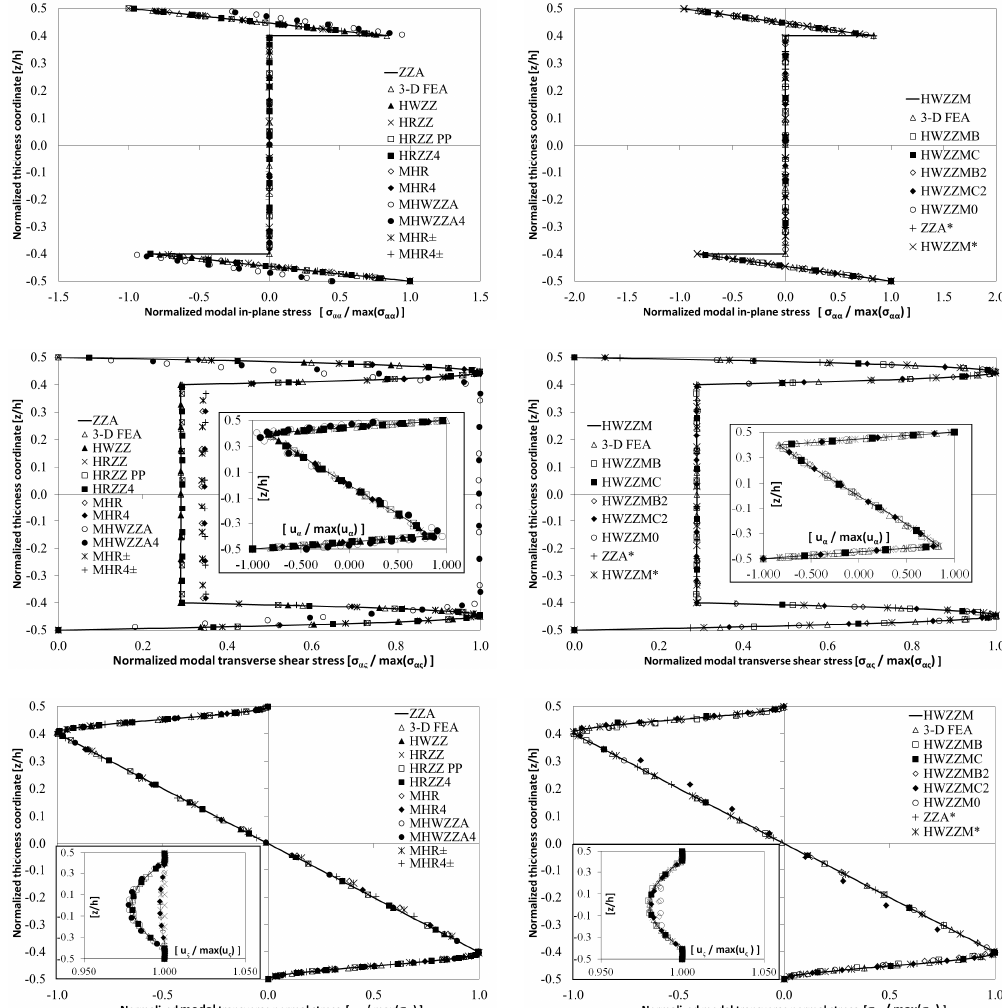
Figure 3. Case b3: Normalized modal displacements and stresses of a simply supported sandwich plate in cylindrical bending ( L x / h = 4).